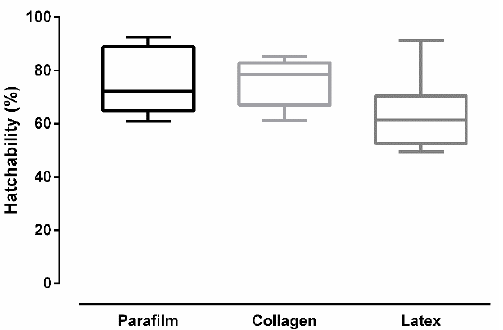
Figure 7. Fecundity of Culex quinquefasciatus females after artificial blood feeding on different membranes (bars = ±SEM).